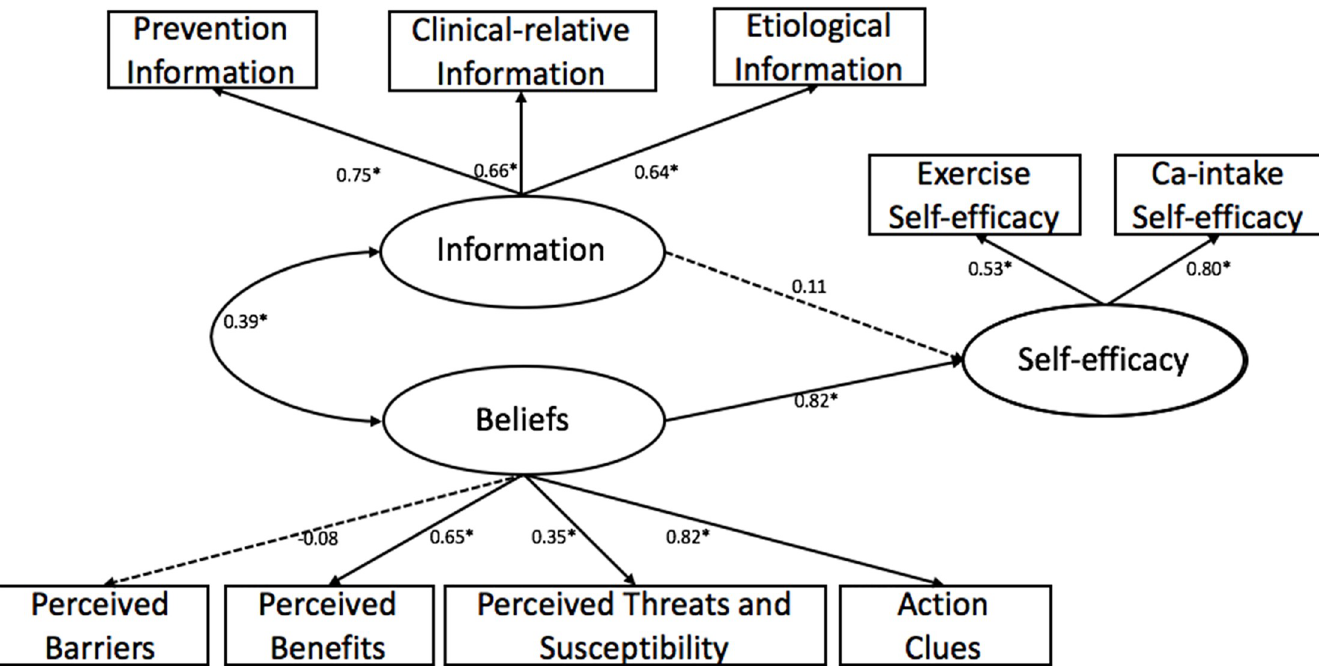
Fig 1. The initial confirmatory pathway, predicting self-efficacy among 421 residuals in Shanghai. Oval represent latent variables; rectangle represent observable variables. Single-headed arrow represent regression path, double-headed arrows represent correlations. Dotted line indicates non-significant path from original model. Regression coefficient are standardized ( � p <